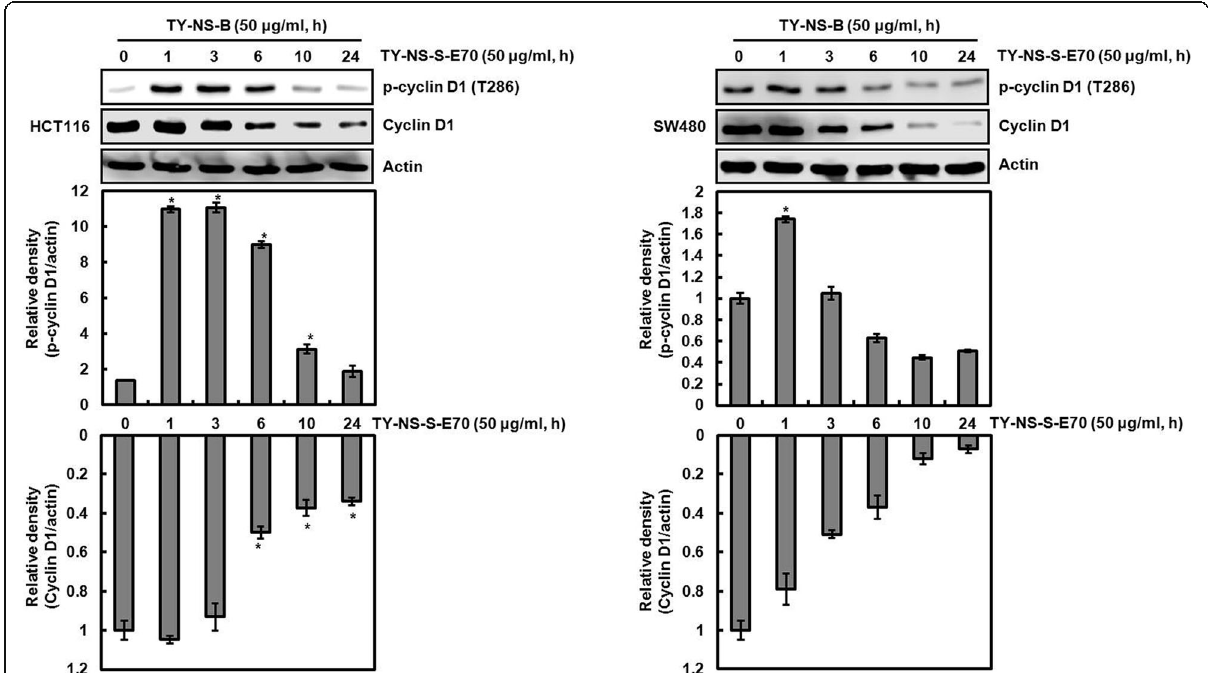
Fig. 5 Phosphorylation of T286 of cyclin D1 by TY-NS-B. HCT116 and SW480 cells were plated overnight and then treated with TY-NS-B (50 μ g/ml) at the indicated times. Cell lysates were subjected to SDS-PAGE and the Western blot was performed using antibody against p-cyclin D1 (T286) and cyclin D1. Actin was used as internal control for Western blot analysis. Relative density for Western blot was measured using the software Un-SCAN-IT